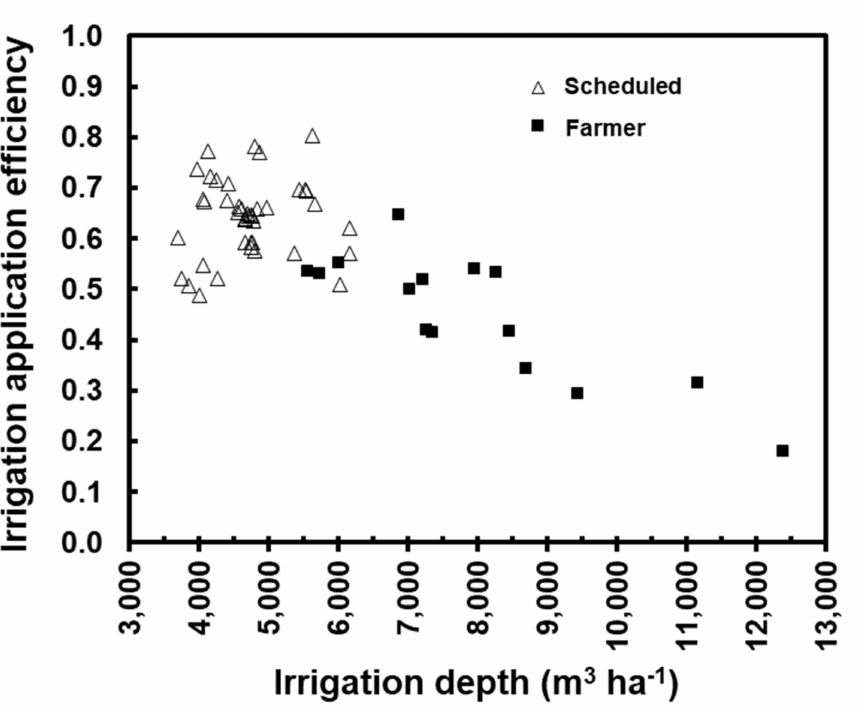
Figure 6. Irrigation application efficiency as a function of the irrigation depth applied according to the irrigation scheduled by IFAPA and farmers in 38 strawberry